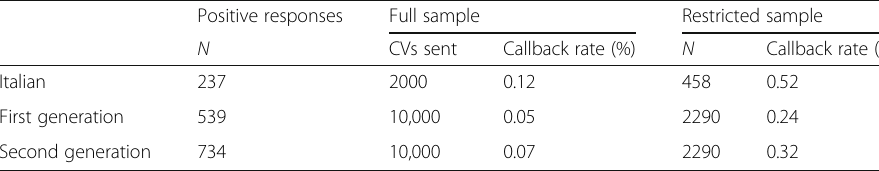
Table 2 Callback rates for the full sample and the restricted